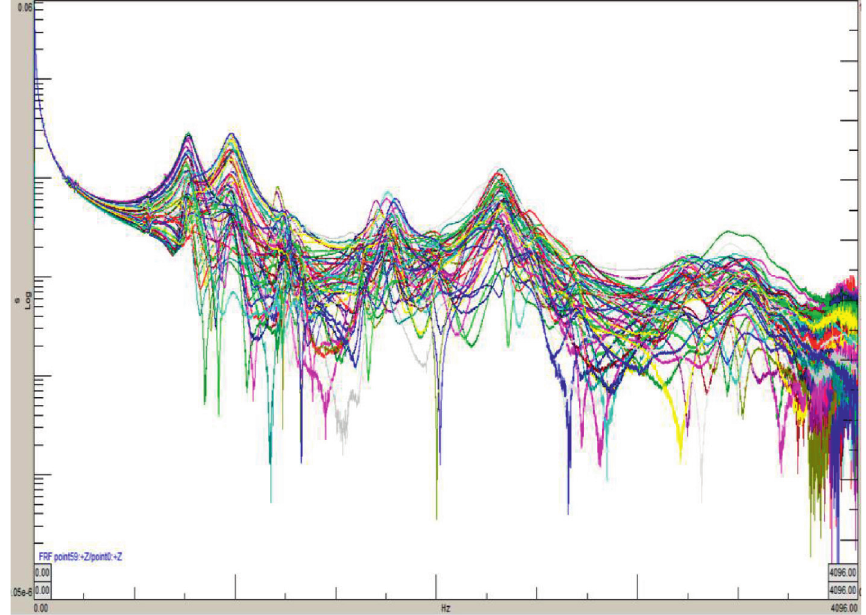
Figure 14: Experimental frequency response function base excitation vs